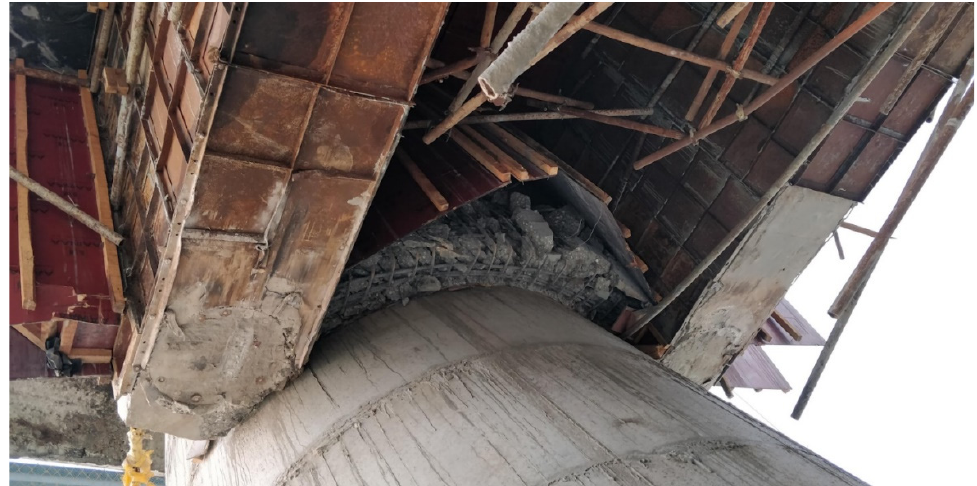
Figure 17. Bearing indentation in the beam with sheared bolts lodged (Pier-2).